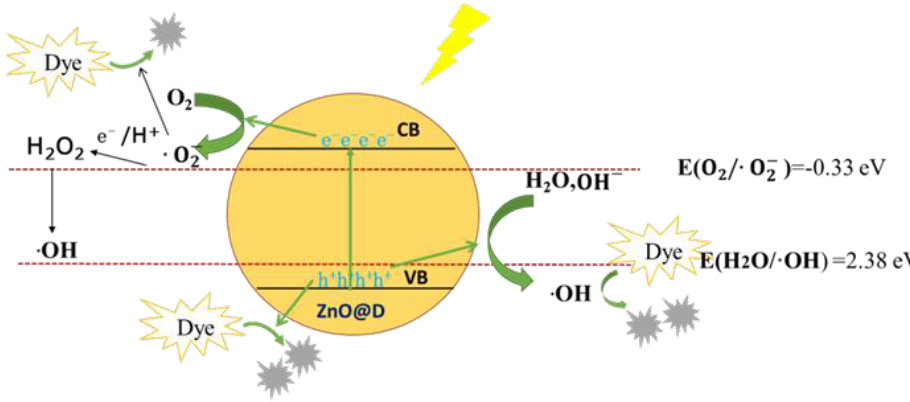
Scheme 1. Schematic illustration of the formation of ZnO@diatomite composite catalysts.